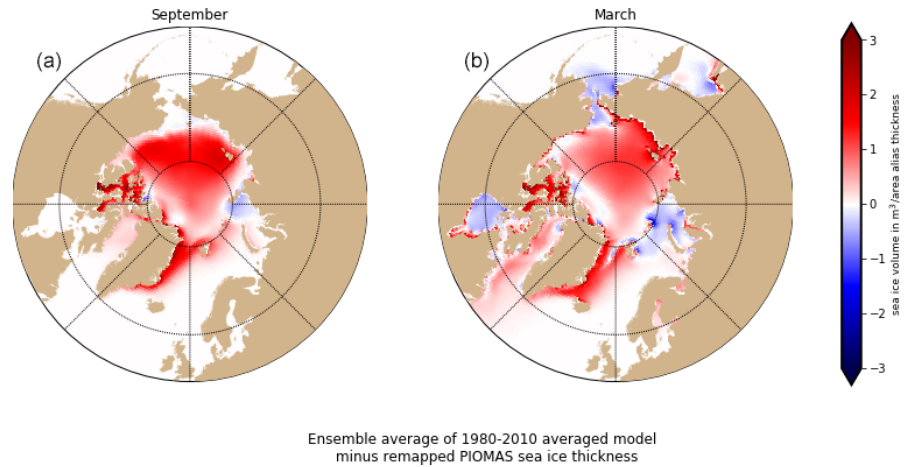
Figure 13. Difference in Arctic sea ice thickness between the ensemble mean of EC-Earth3 and PIOMAS in September (a) and March (b) , averaged over 1980–2010.